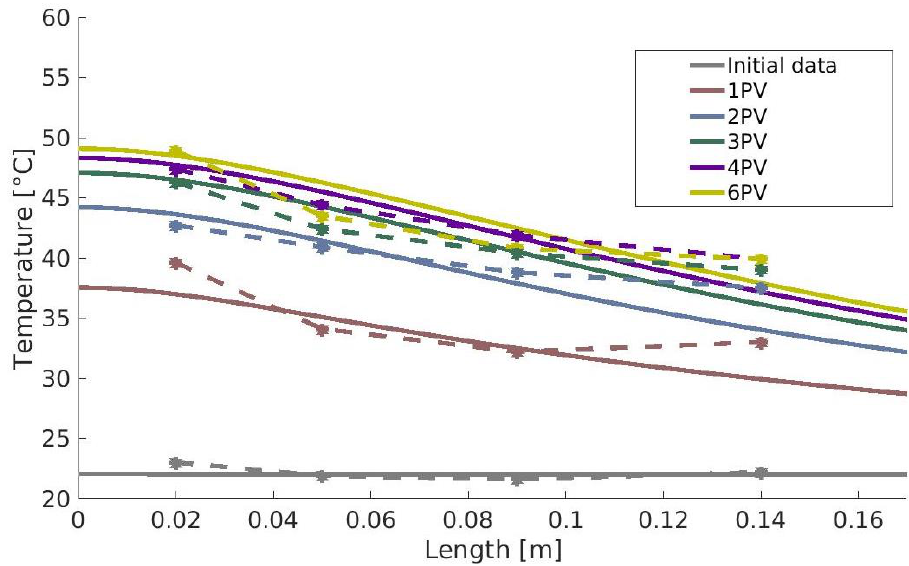
Figure A2. Temperature profiles for Experiment B (EM heating and flooding). The continuous lines represent the model’s solution, and the dots represent data obtained by optical thermometers